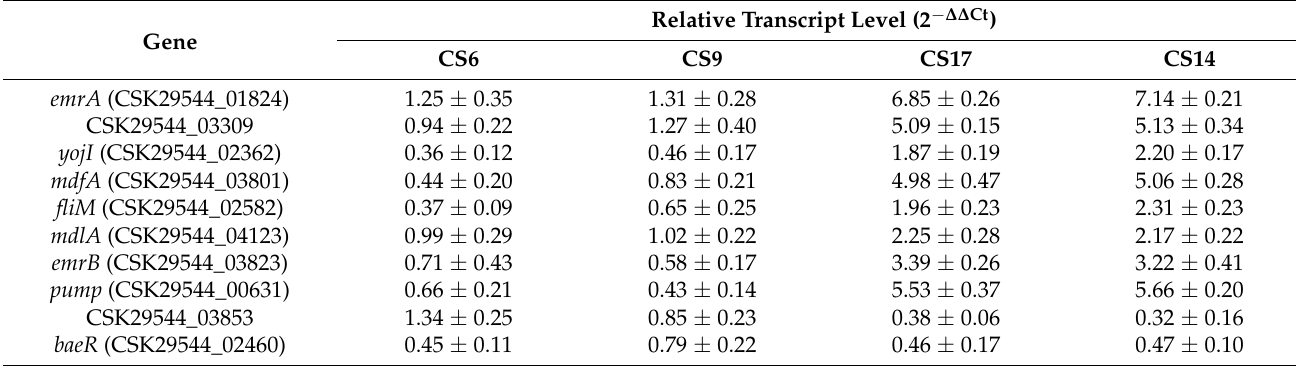
Table 6. Changes in relative expression levels of some drug resistant differentially expressed genes by